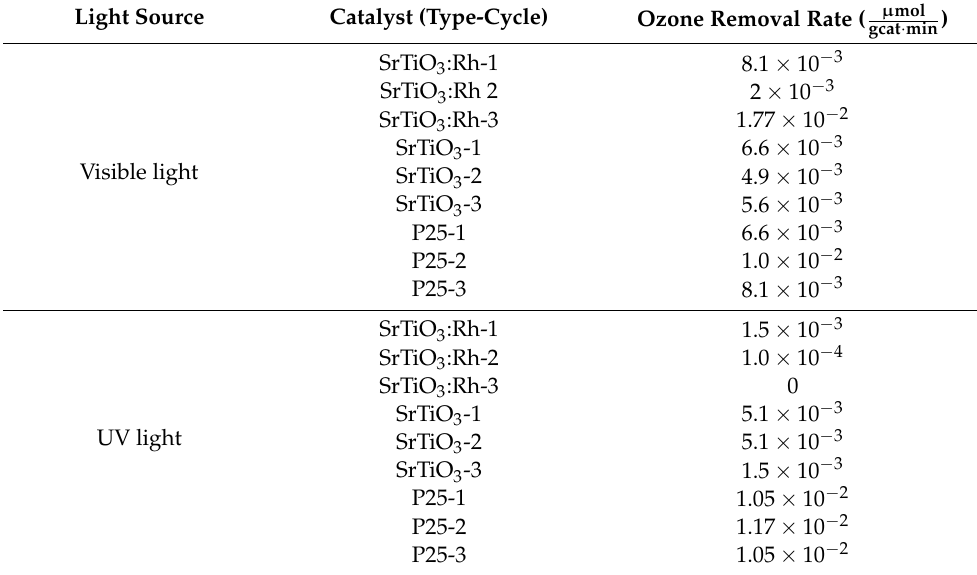
Table 1. The ozone removal rate for three catalysts in a batch system under two different light